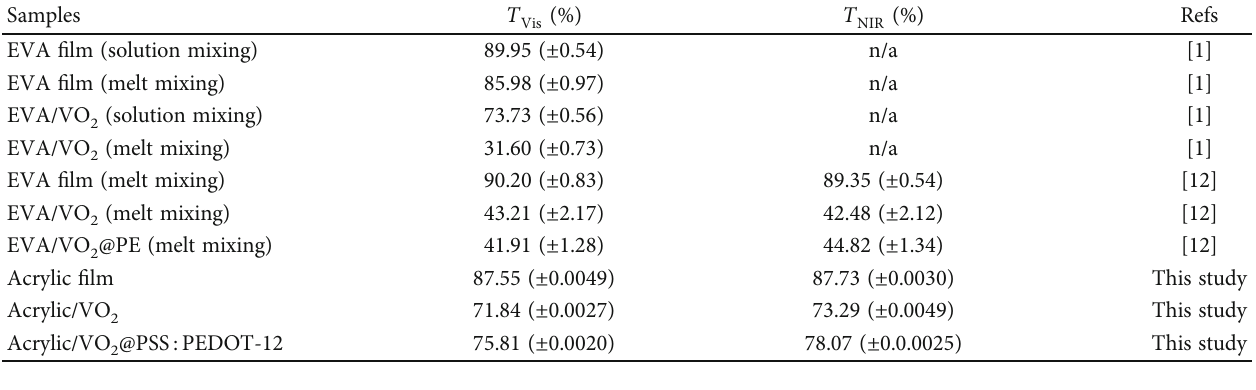
Table 4: Comparison of optical properties of various polymer composite fi lms containing di ff erent types of VO